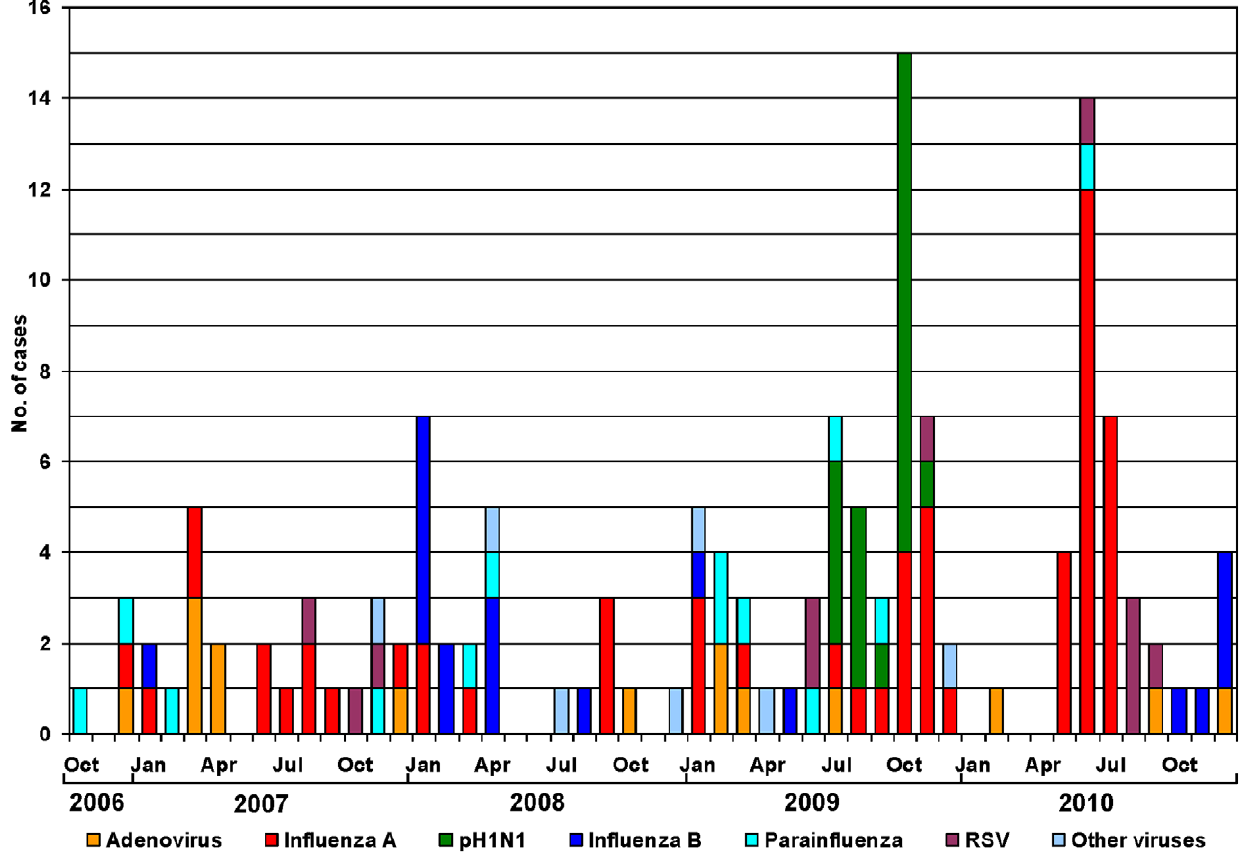
Figure 3. Monthly distribution of acute febrile respiratory viral infections by different viruses detected through a passive surveillance in two health centers of Maracay.